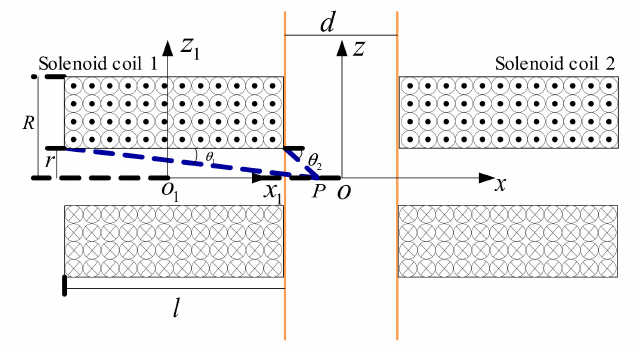
Figure 2. Two-dimensional coordinate system of double solenoid